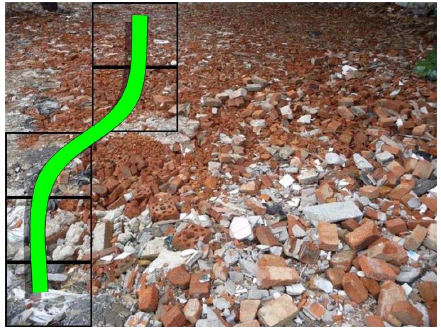
Fig. 20. The final optimal path for the experiment 3.